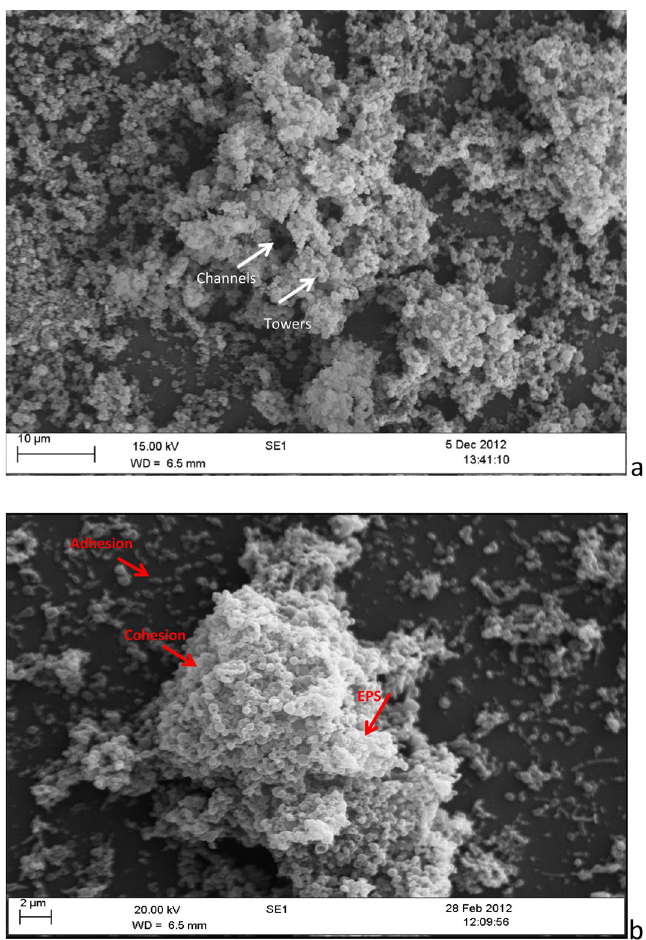
Figure 2. Scanning electron microscopy image of Mycoplasma fermentans ATCC19989 biofilm on glass coverslip illustrating complex biofilm architecture such as ( a ) channels and towers, ( b ) extracellular polymeric substances (EPS) embedding biofilm cells, adhesion and cohesion attachment of mycoplasma cell clusters